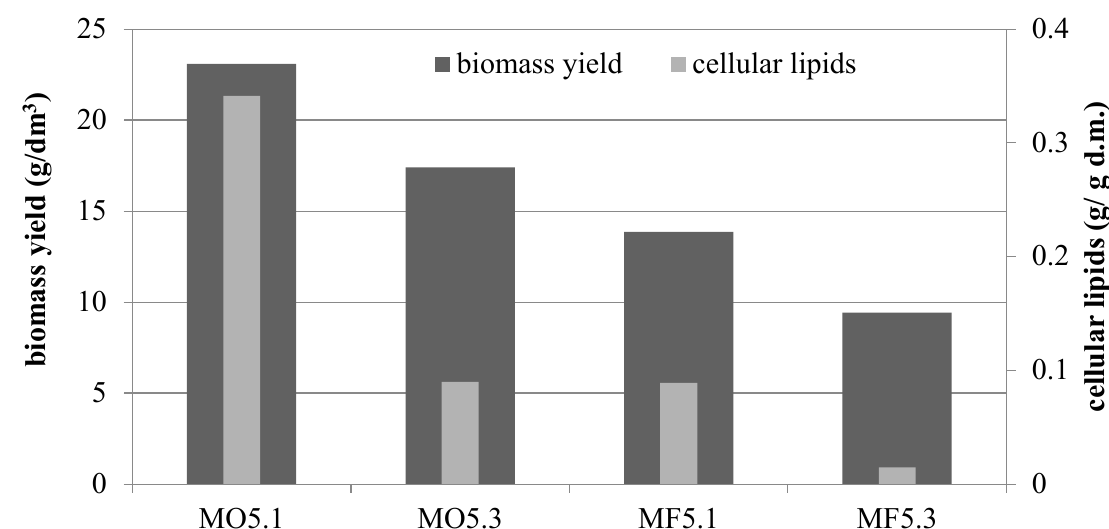
Figure 4. Comparison on biomass yield and cellular lipids amount isolated from yeast biomass cultured in batch bioreactor differing in carbon source in medium (olive oil—MO5 or waste fish oil—MF5) and amount of inoculum (0.0025% v/v— 1; 0.0075% v/v— 2).